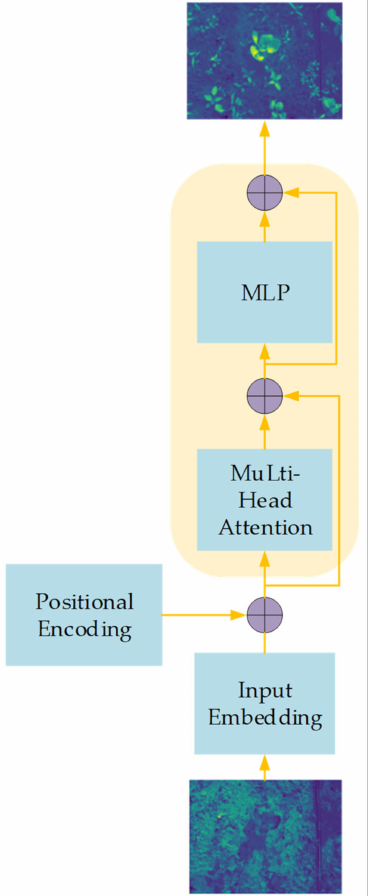
Figure 1. Structural diagram of the